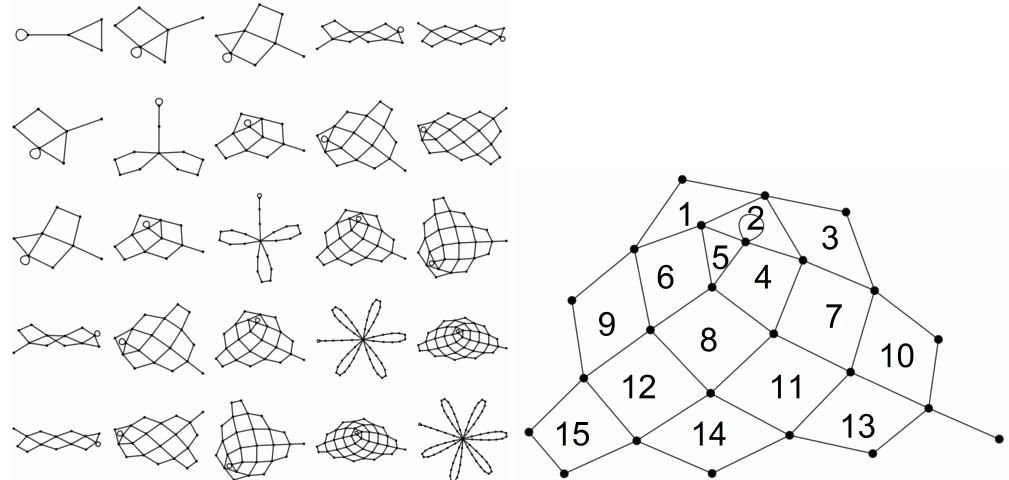
Figure 18. A graph multiplication table for the first five odd primes, A p , where p = q i · q j . The “product” − 1 · q j − 1 is a web graph with q i faces ( q i (cid:54) = q j ). The faces consist of one triangle and the remainder are 2 2 quadrilaterals. The example of A 77 is shown on the right with the faces